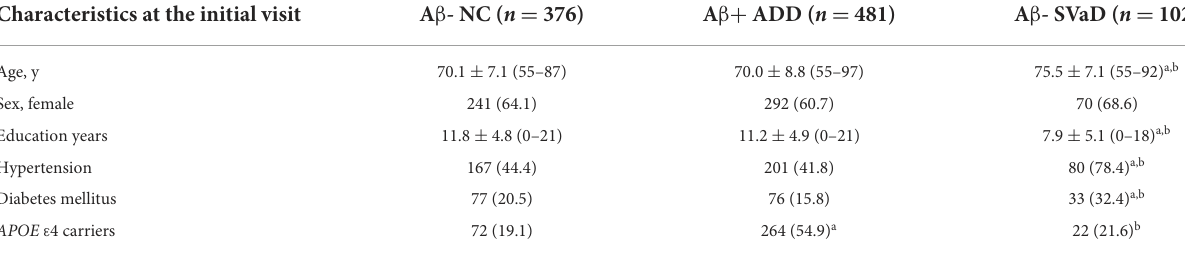
TABLE 1 Demographics and clinical characteristics.